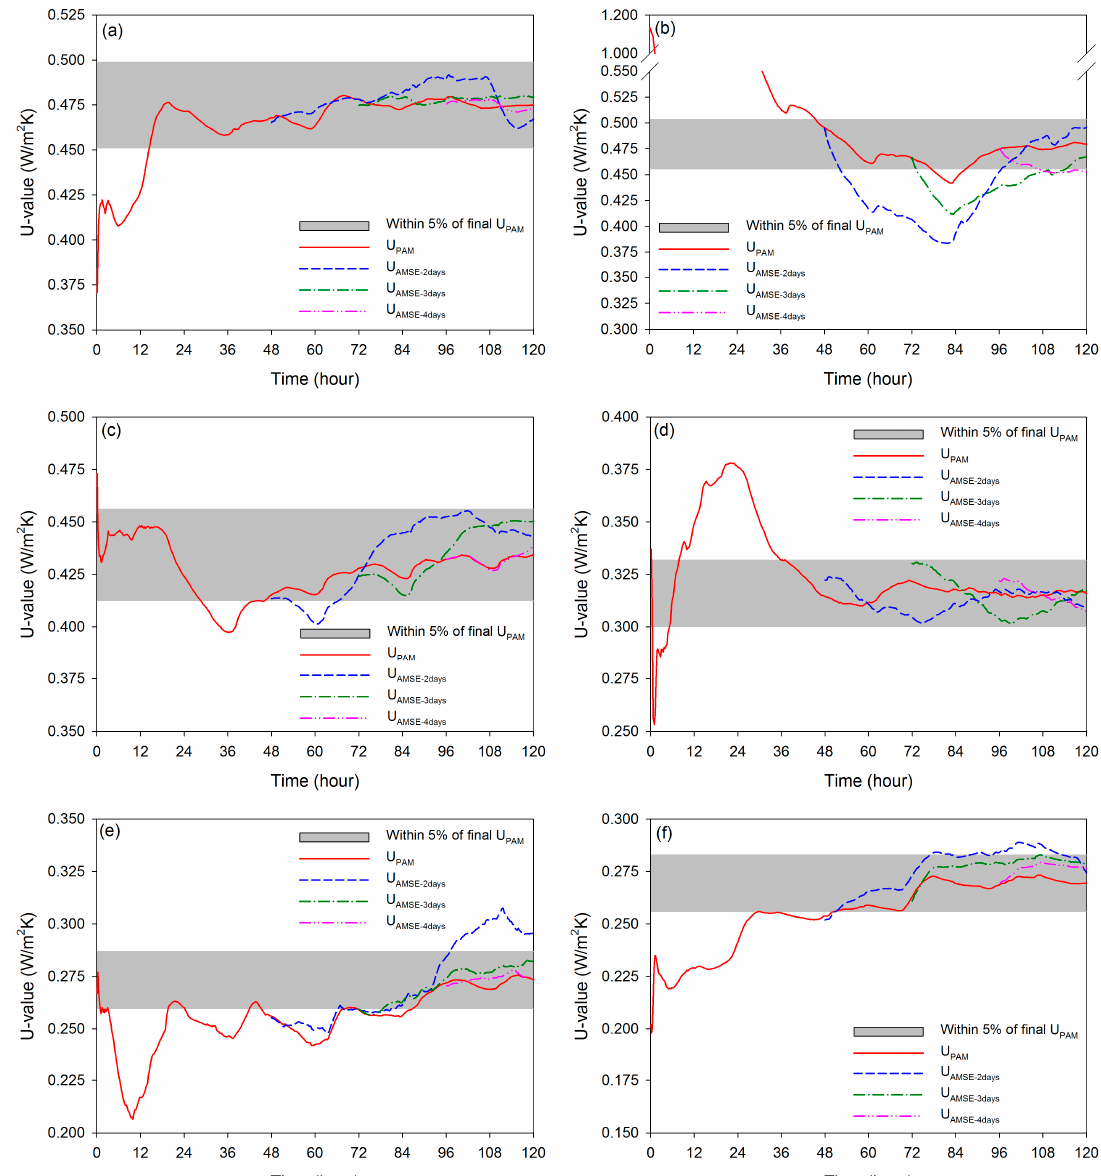
Figure 5. Evolution of U -values corrected by applying thermal storage effect: ( a ) Case 1; ( b ) Case 2; ( c ) Case 3; ( d ) Case 4; ( e ) Case 5; ( f ) Case 6.